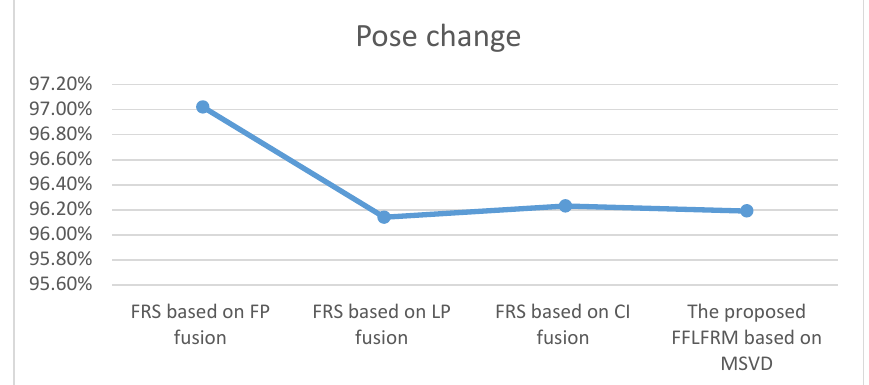
Fig. 4. Recognition accuracies of the four studied FRSs under the condition of pose change.